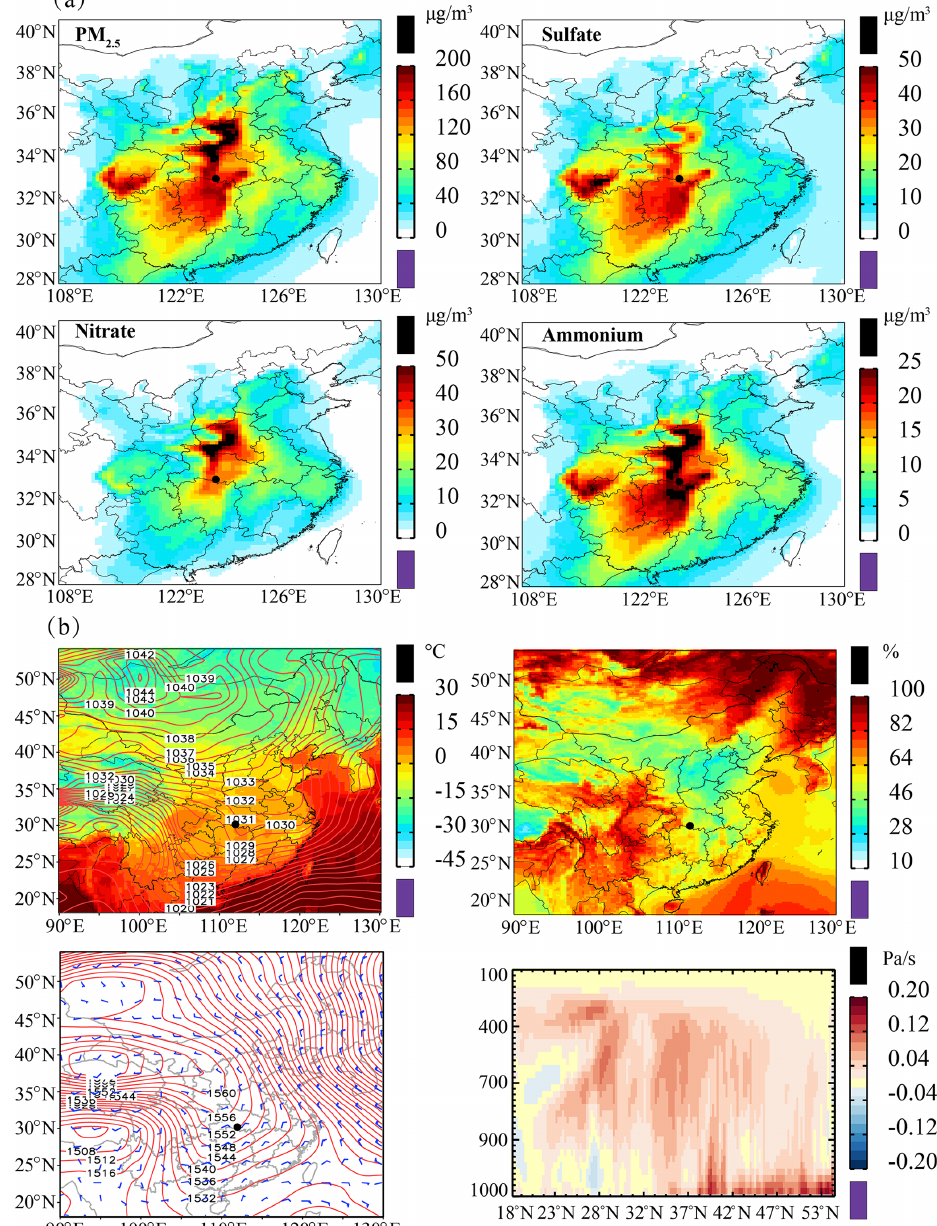
Figure 9. The same as Fig. 7 but for NW-type synoptic control (19–26 December